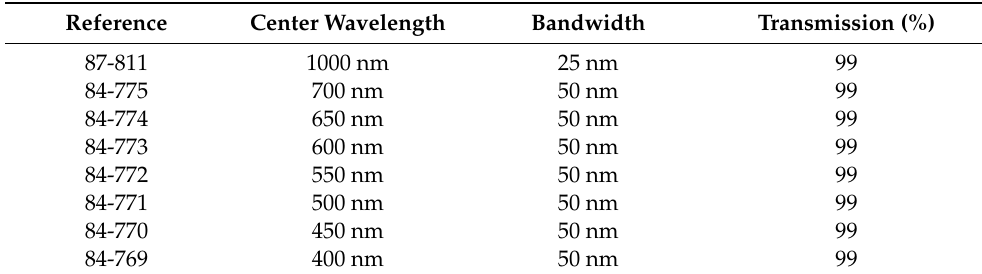
Table 2. Characteristics of bandpass filters.